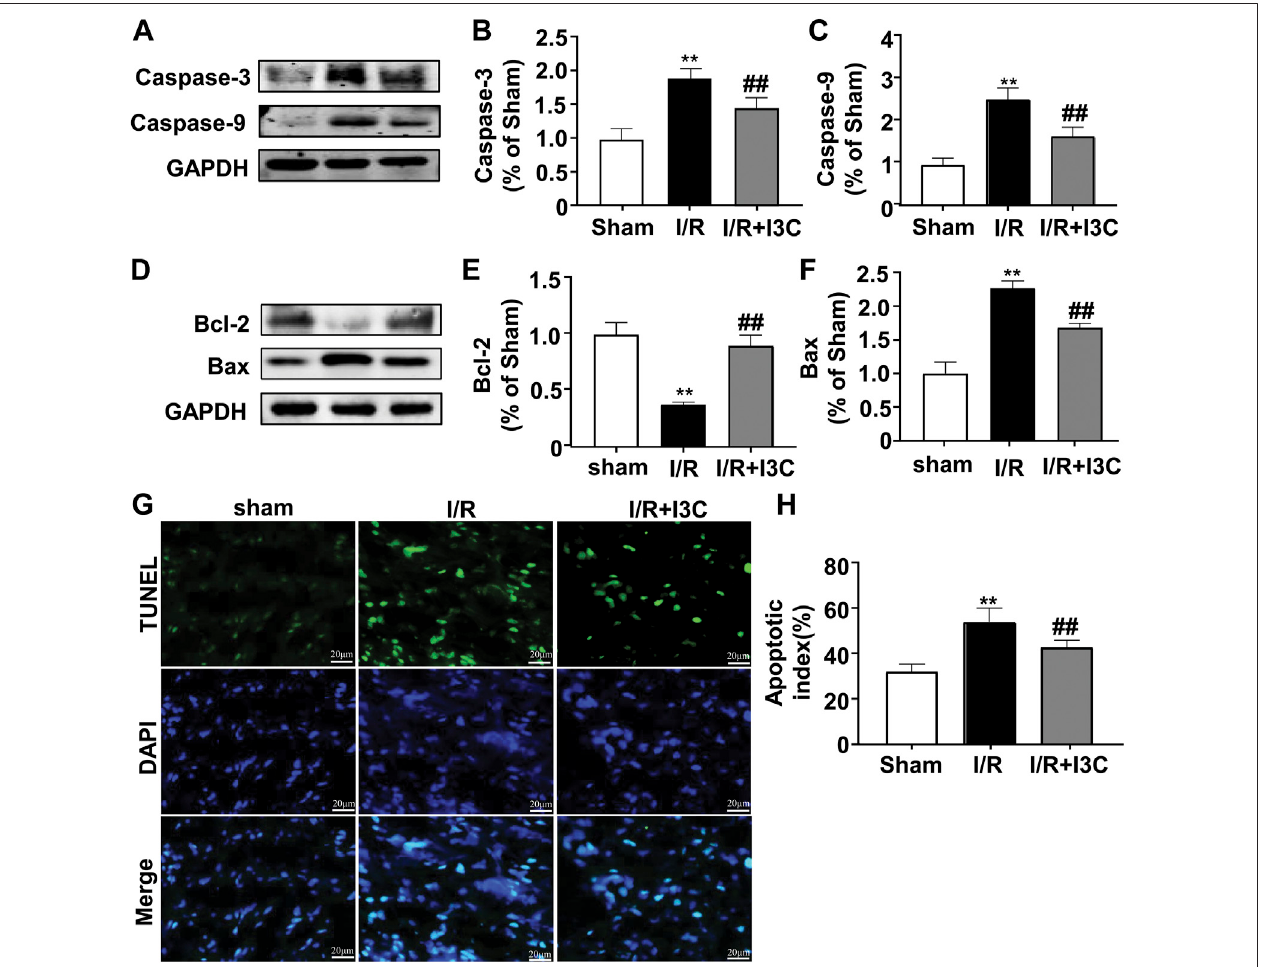
FIGURE 2 | Effect of I3C on cardiac apoptosis induced by I/R. (A – C) Representative images and quantitative analysis showed that I3C pretreatment (100 mg/kg) prevented the I/R-induced increase in the expression levels of caspase-3 (A,B) and caspase-9 (A,C) in ischemic cardiac tissue ( n = 5, ** p < 0.01 vs. sham treatment, ## p < 0.01vs.I/R) (D – F) Representative imagesandquantitativeanalysisshowedthatI3CpretreatmentpreventedtheI/R-induceddecreaseinexpressionlevelsofBcl- 2 (D,E) and the I/R-induced increase in expression levels of Bax (D,F) in ischemic heart tissue ( n = 5, ** p < 0.01 vs. sham treatment, ## p < 0.01 vs. I/R).